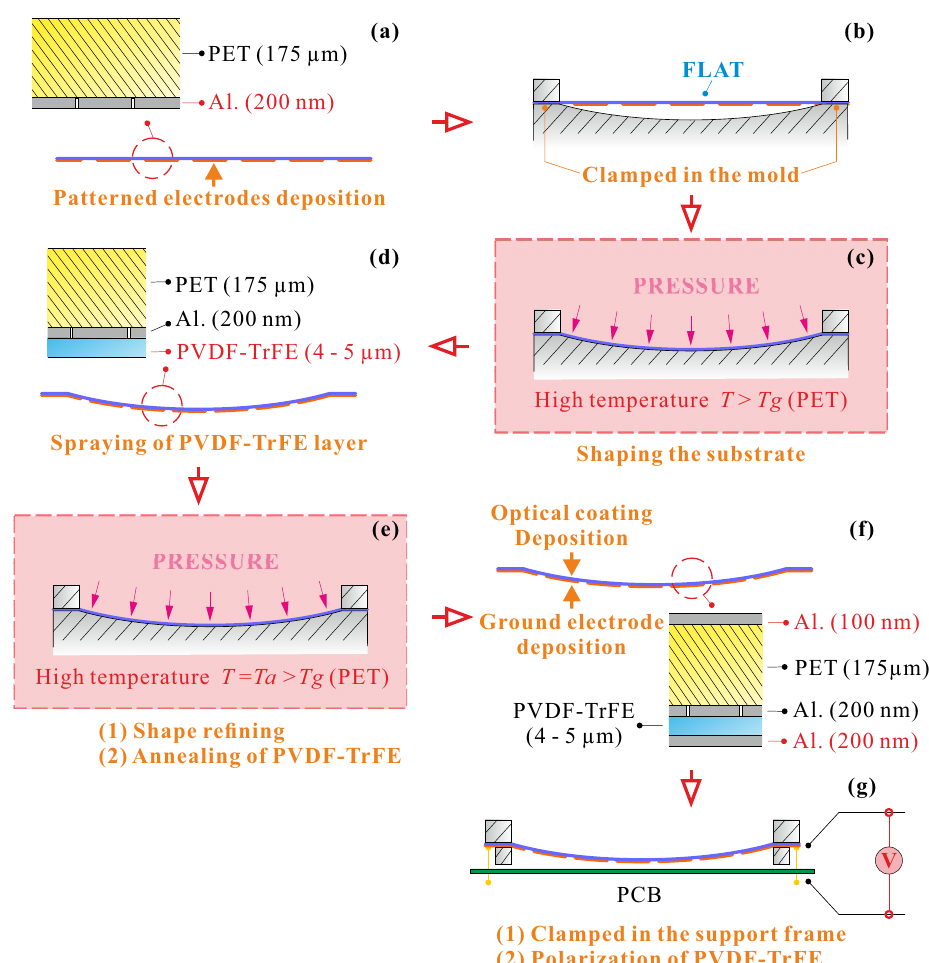
Figure 2. Flow chart of the manufacturing sequence of the Multilayer Adaptive Thin Shell Reflectors for Future Space Telescopes (MATS) demonstrator.